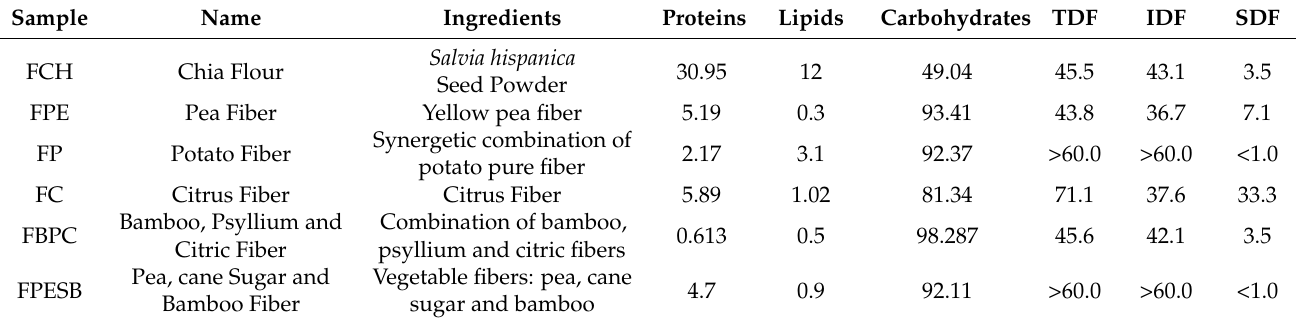
Table 1. Sample names, ingredients and proximate compositions expressed as g/100 g